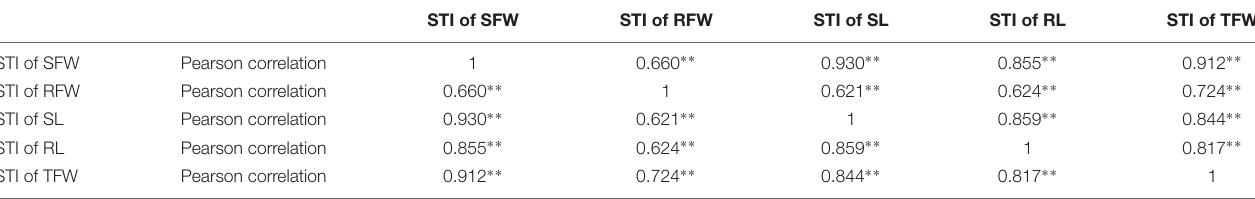
TABLE 1 | Correlation analysis between salt tolerance indices of shoot fresh weight (STI of SFW), root fresh weight (STI of RFW), shoot length (STI of SL), root length (STI of RL), and total fresh weight (STI of TFW) of 438 B. napus inbred lines in the presence of 200 mmol L − 1